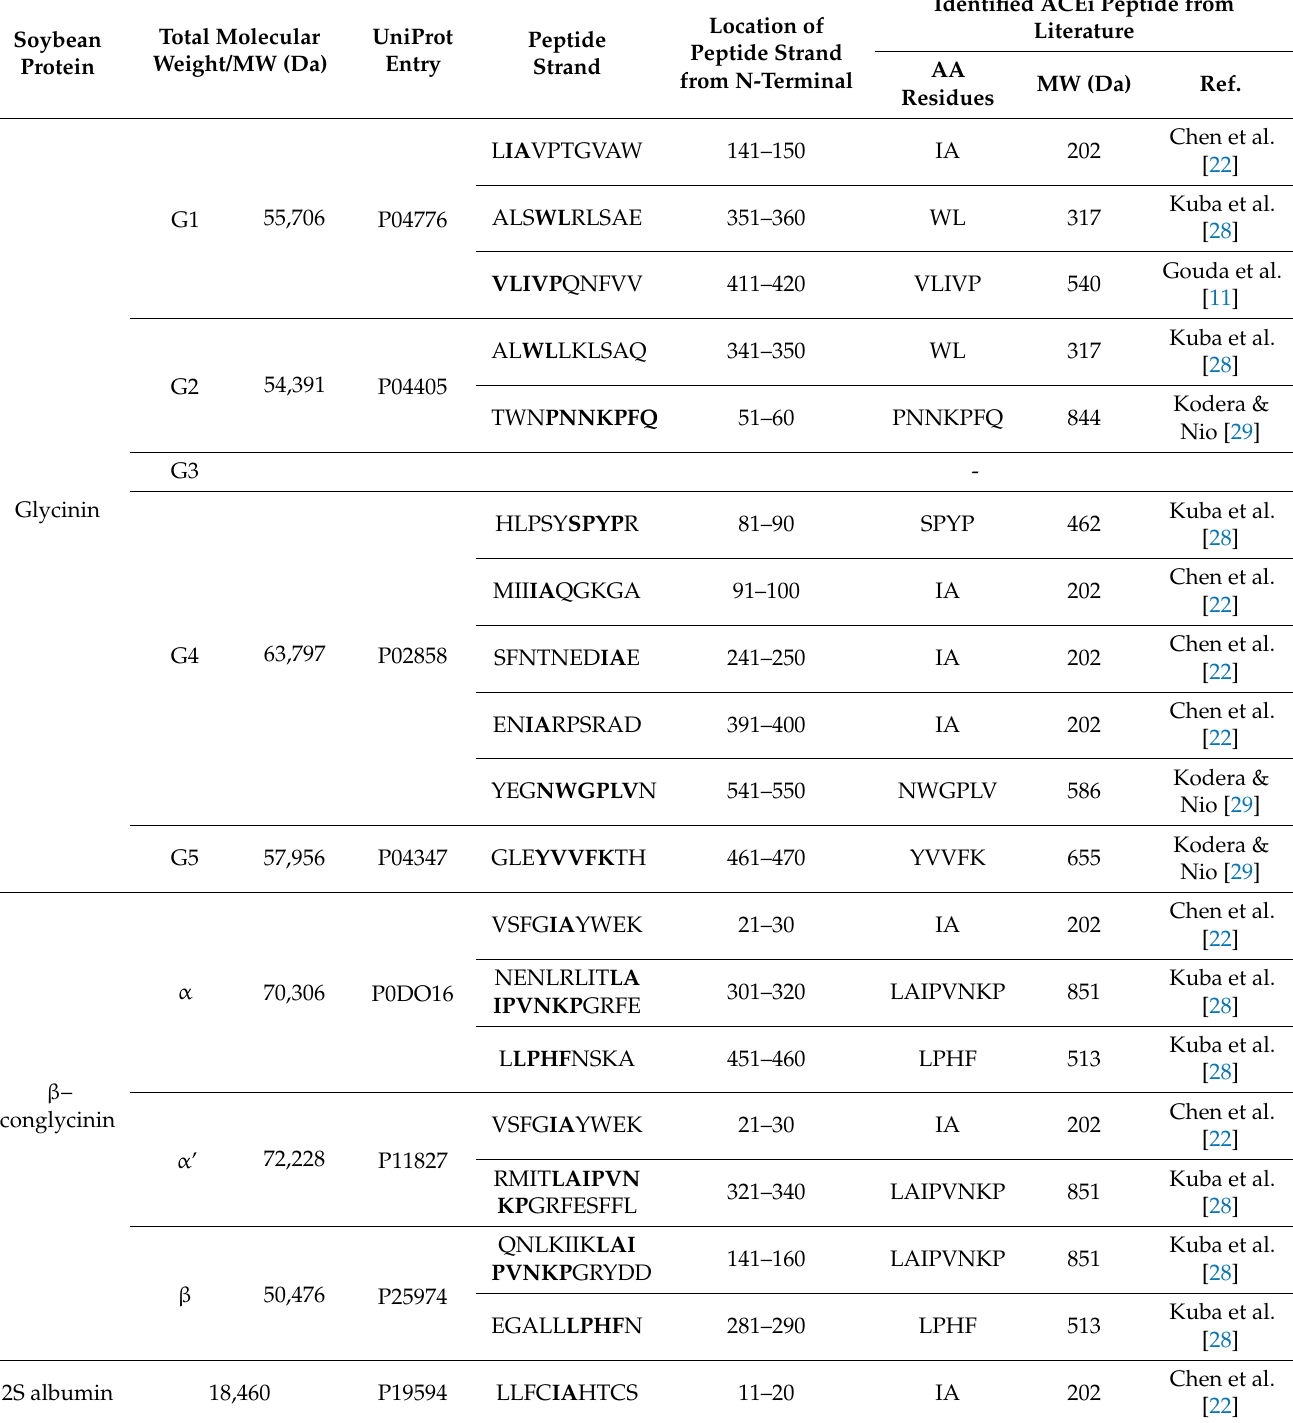
Table 3. Identified ACEi peptides and their corresponding specific soybean proteins as sources.